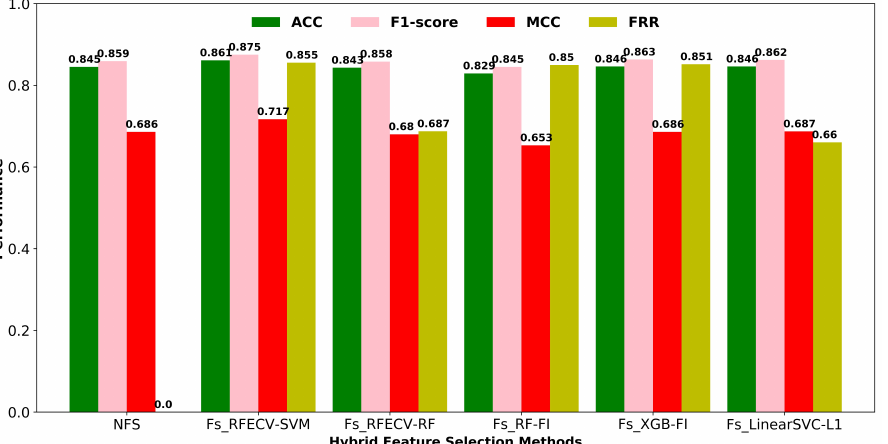
Figure 4. Hybrid feature selection methods with 2-stages. NFS: No feature selection; Stage 1: Fs (Low variance filtering and high correlation filtering using Pearson’s correlation coefficient); Stage 2: Wrapper based RFECV feature selection, Tree based embedded feature selection (FI-Feature Importance), and L1-based embedded feature selection.